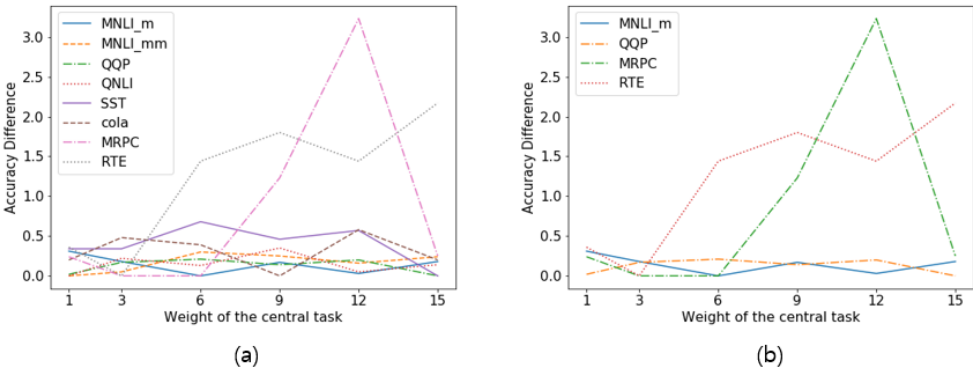
Figure 3. Accuracy variance according to the task weight change. ( a ) amount of change in accuracy for each dataset except STS-B; ( b ) amount of change in accuracy for four datasets belonging to the Pairwise Text Classification. Accuracy difference = (accuracy at each weight − minimum